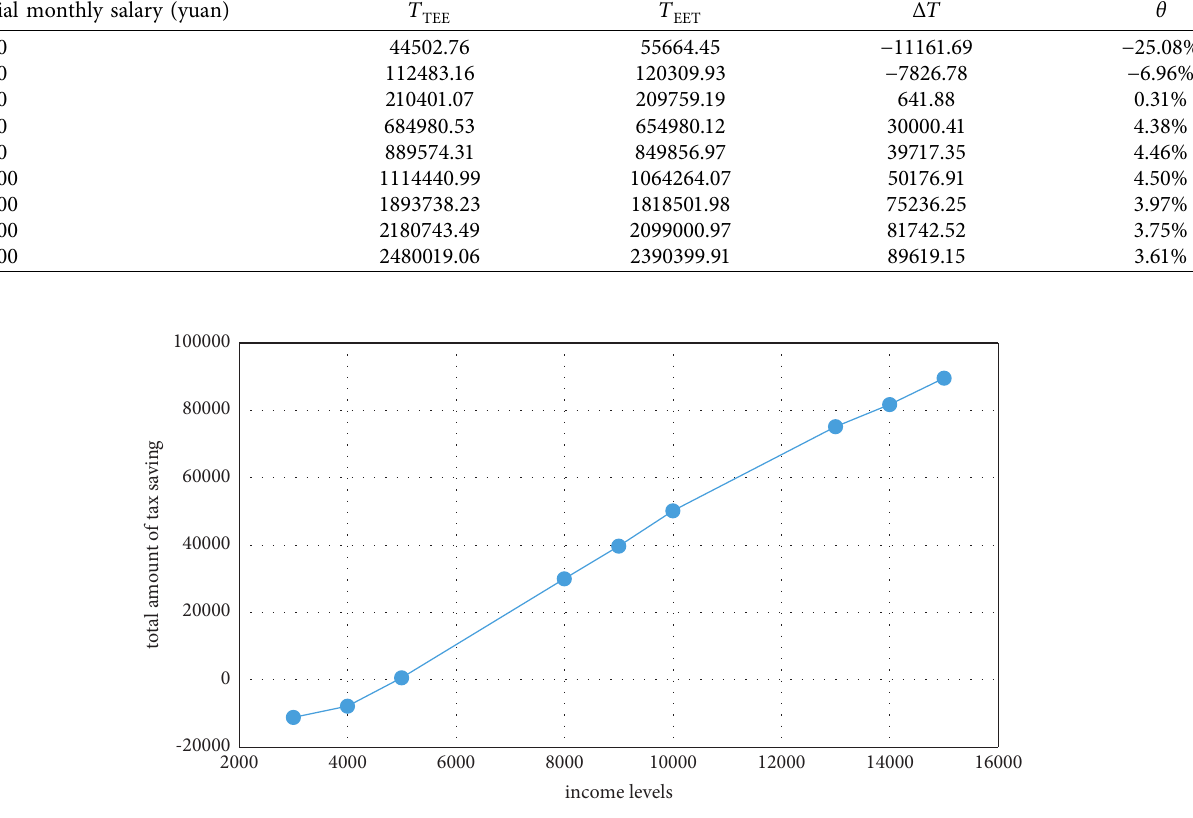
Figure 1: The total amount of tax savings under different income levels. Table 2: Division table of income